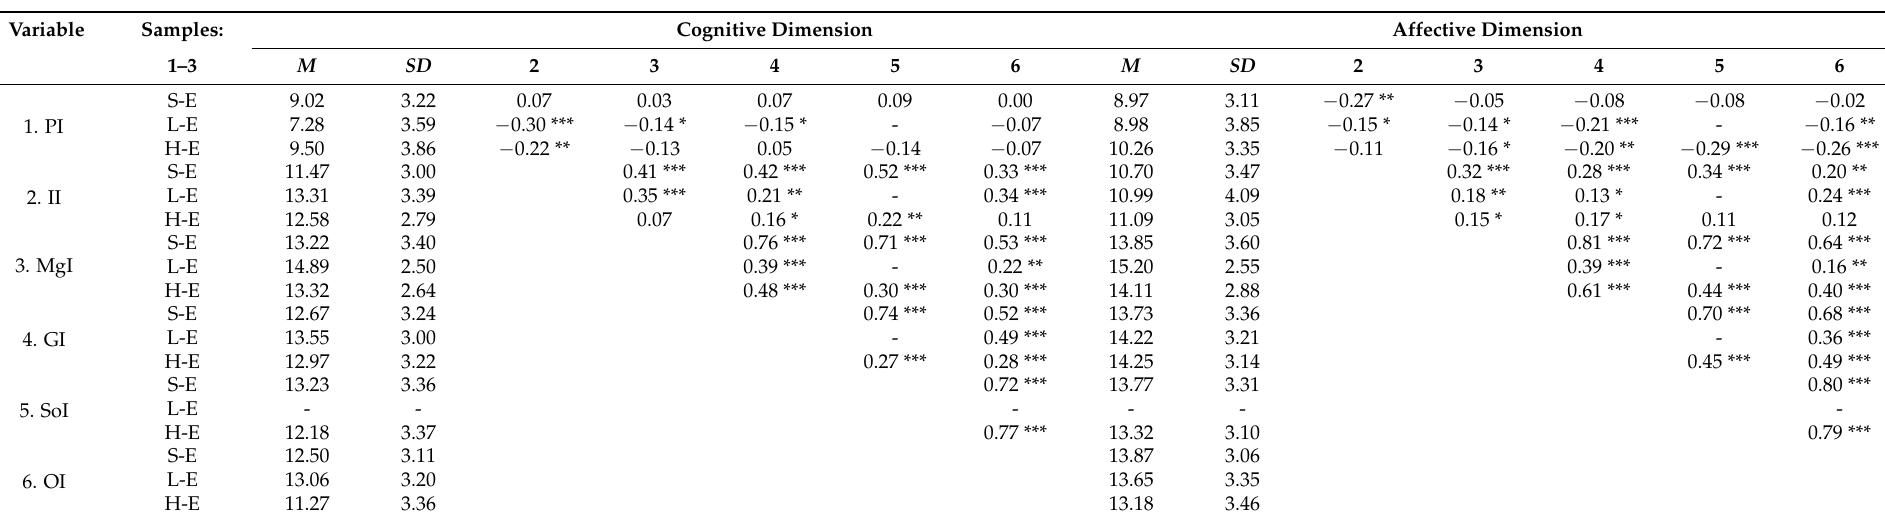
Table 1. Descriptive Statistics and Inter-correlations Among Variables.